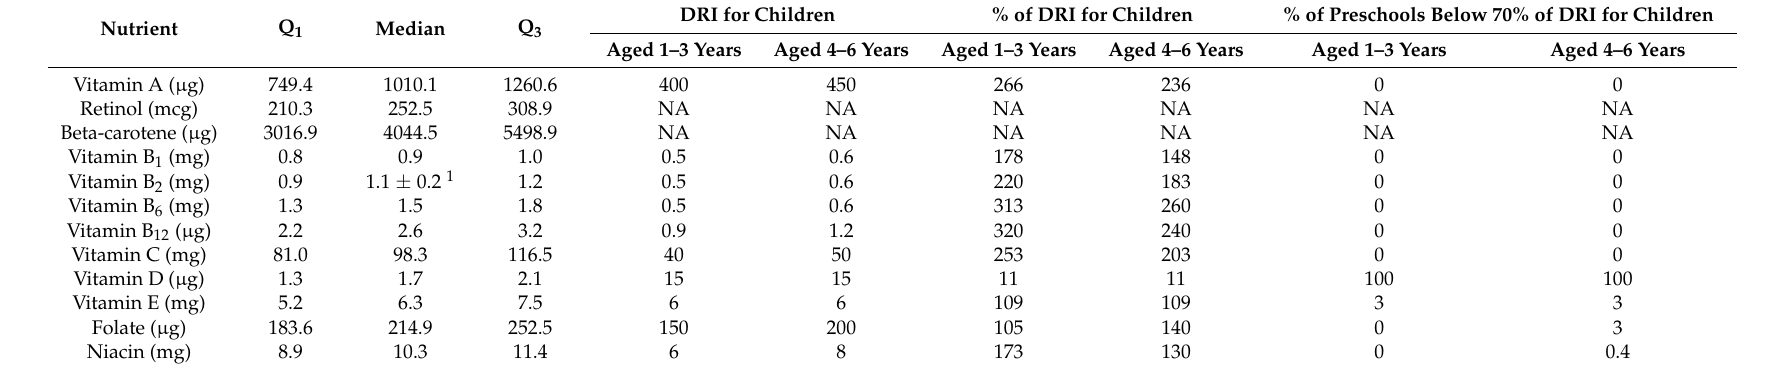
Table 2. Vitamins provided in preschools ( n = 270) menus per child per day and the age-specific dietary reference intake (DRI). Nutrient